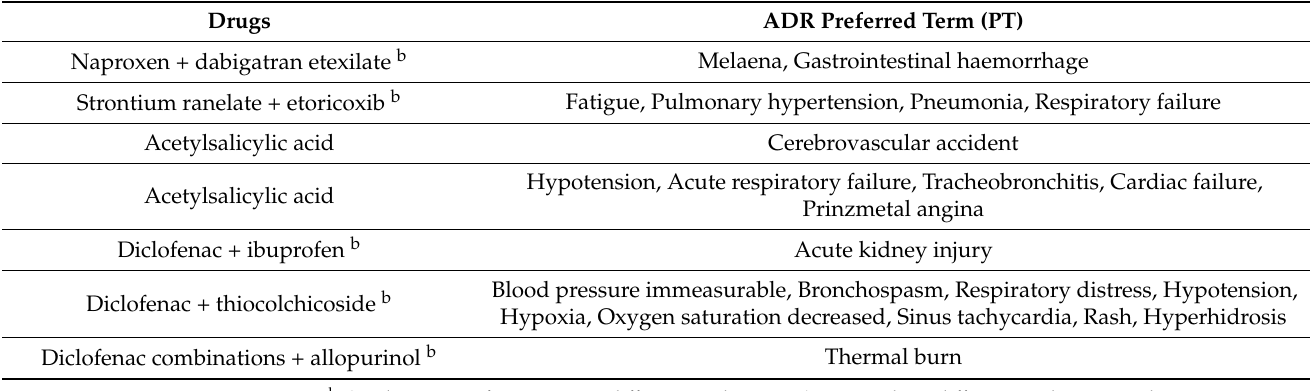
Table 4. Adverse Drug Reactions (ADR) and suspected drugs associated with a fatal